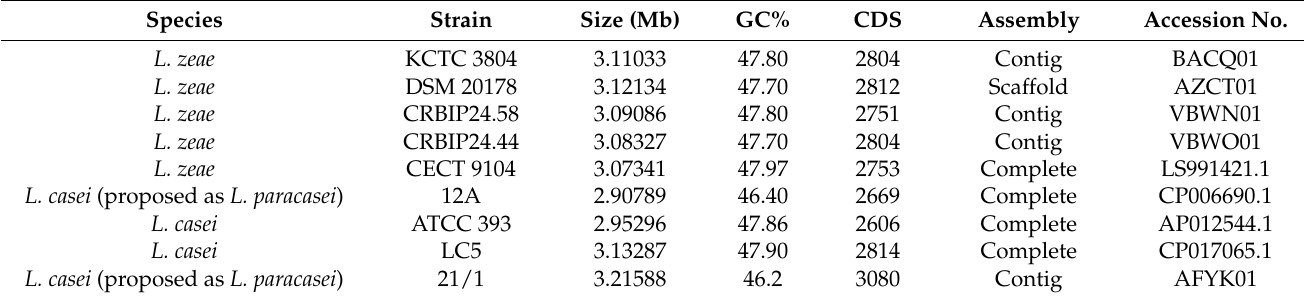
Table 1. Genome features used in the